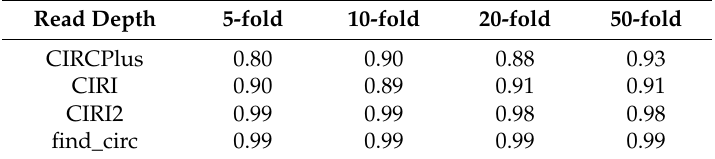
Table 1. Precision analysis of detection under different read depths of circular transcripts.